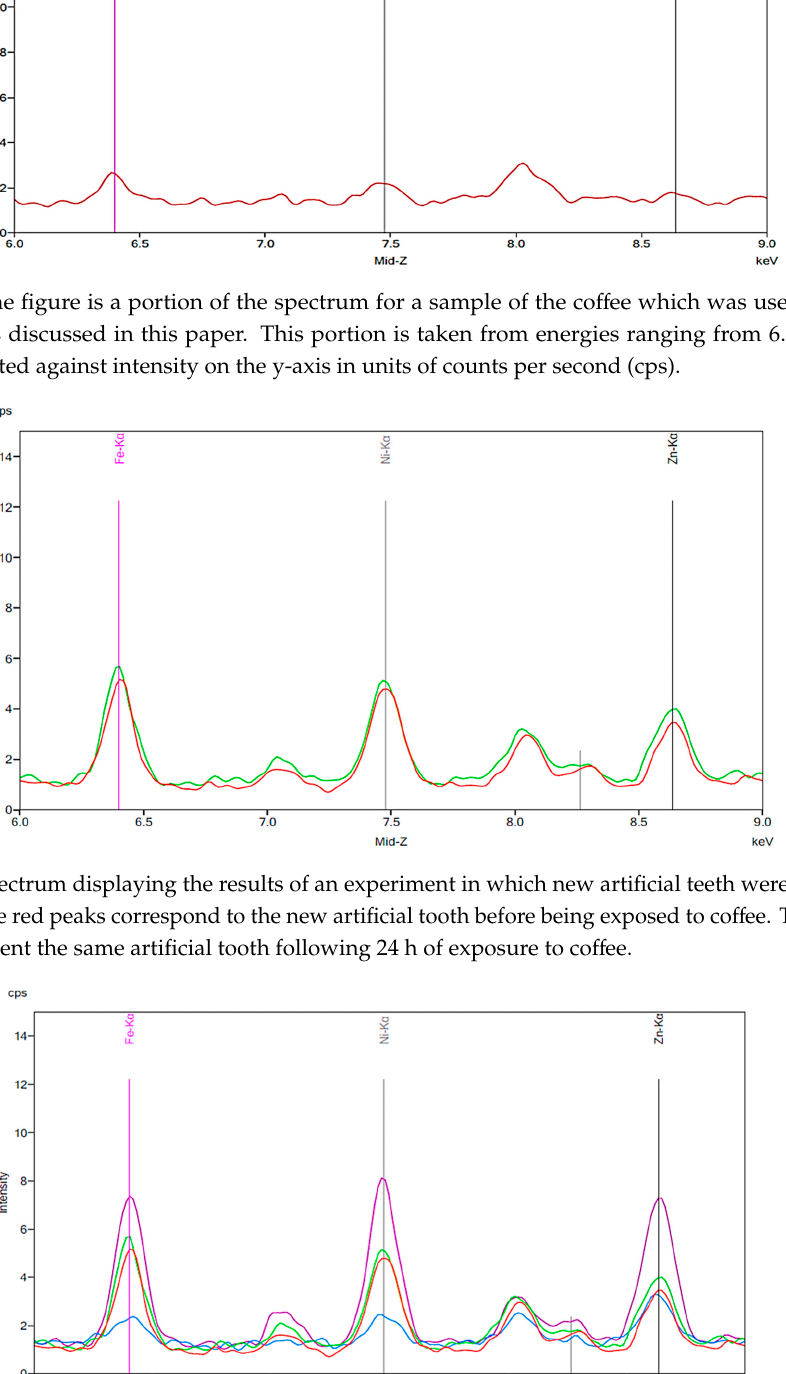
Figure 4. The same results as Figure 3 are indicated by the red and green peaks. The blue peaks on this figure represent a new artificial tooth that has been mechanically worn down. The purple peaks indicate the spectrum of an artificial resin tooth after wear following 24 h exposure to coffee.